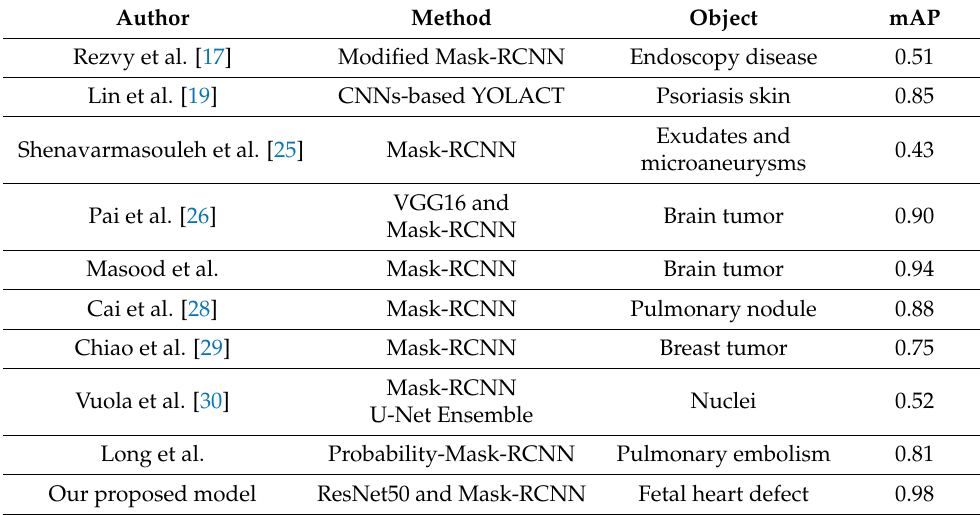
Table 7. Research benchmarks with other medical object detection with CNNs